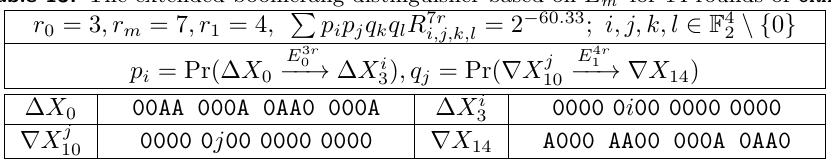
Table 15: The extended boomerang distinguisher based on E 7 r m for 14 rounds of CRAFT